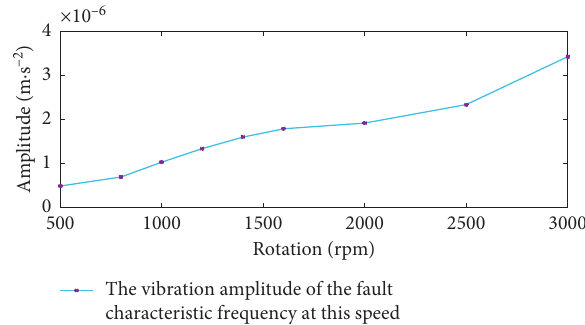
Figure 21: The trend of different rotation speeds when load is 500N and defect is 0.014